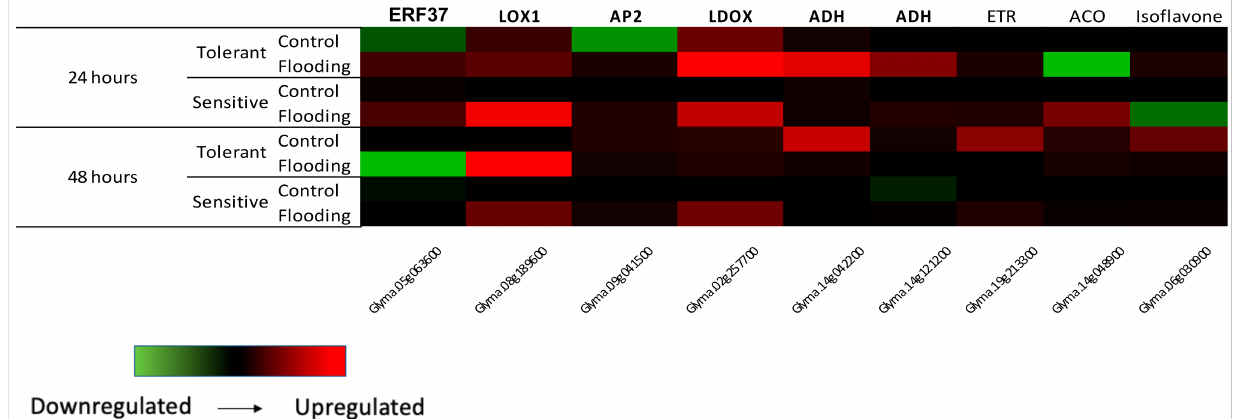
Figure 1. Real-time validation of RNA-Seq